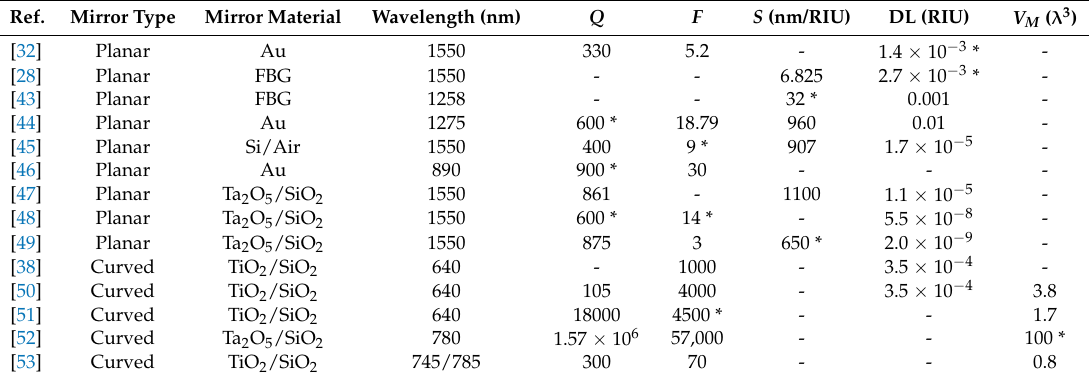
Table 1. Summary of chip-based FPCs used for refractometric